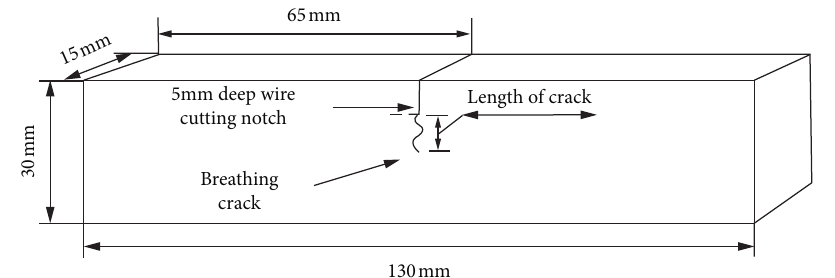
Figure 2: The schematic diagram of specimen. Table 1: The parameters of specimens. Parameters of